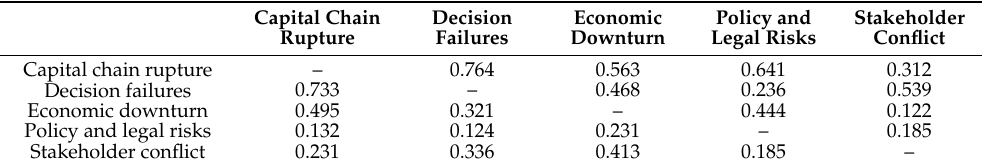
Table 7. Direct-relation matrix M .